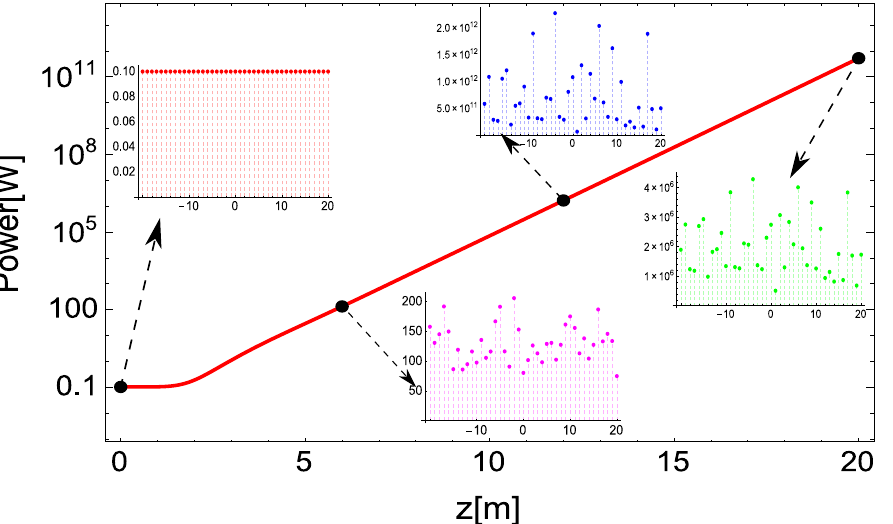
Figure 10. Same as Figure 9—all slices with the same energy spread and the maximum current associated with the rear part of the bunch ( s ∗ = 1). Slice evolution vs z and intensity evolution vs. z . The slices are characterized by the same amount of charge and different values of the energy spread with λ u = 0.015, ρ 0 = 0.0011, σ ε = 0.05, σ d = 0.002, δ = 0.01 and I 0 = 10 − 1 . The intensity growth does not refer to a single slice but to the relevant average. The slices have a flat distribution in z , and each is characterized by an initial seed of 0.1 W. The vertical axis is in log-scale; the insets are plotted in linear